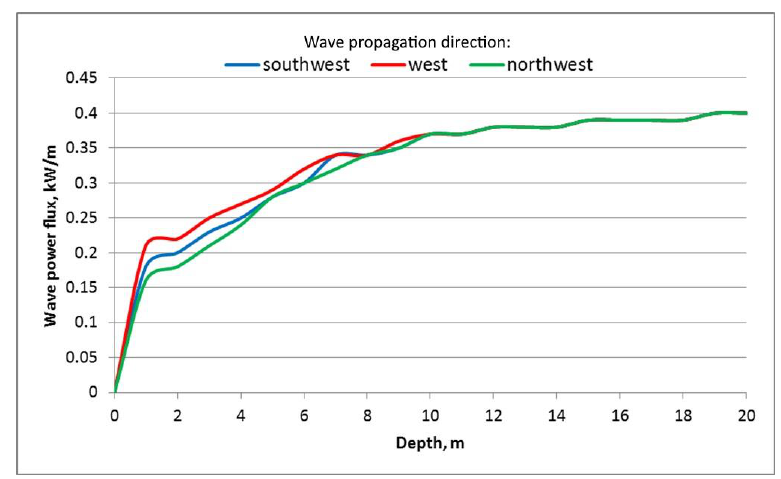
Figure 8. The impact of decreasing depth on wave power flux for a 0.48 m wave.